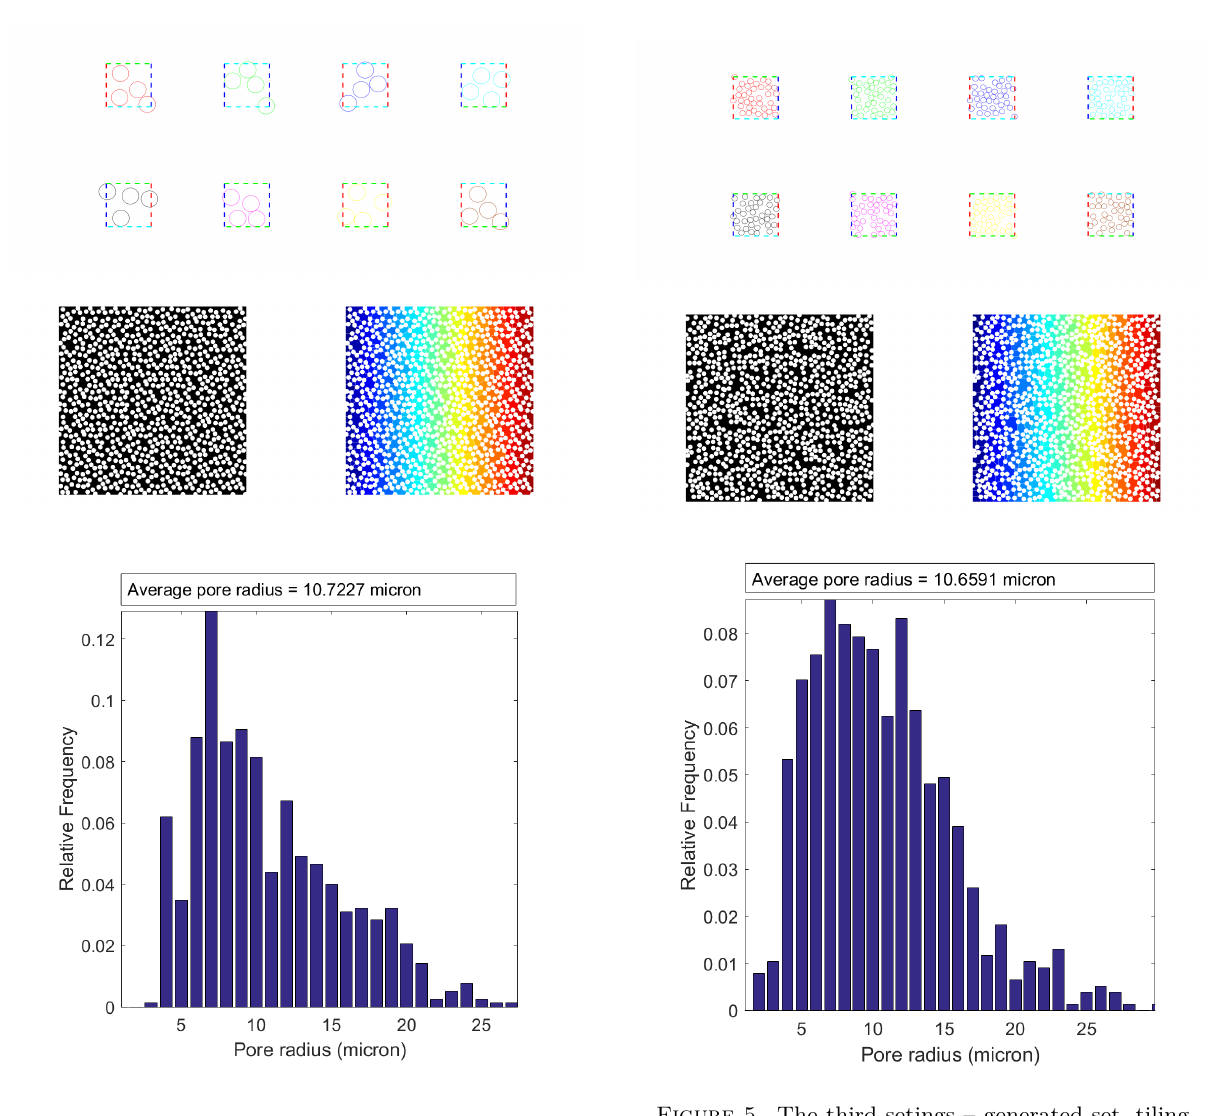
Figure 4. The second setings – generated set, tiling with pores, pore size distribution.